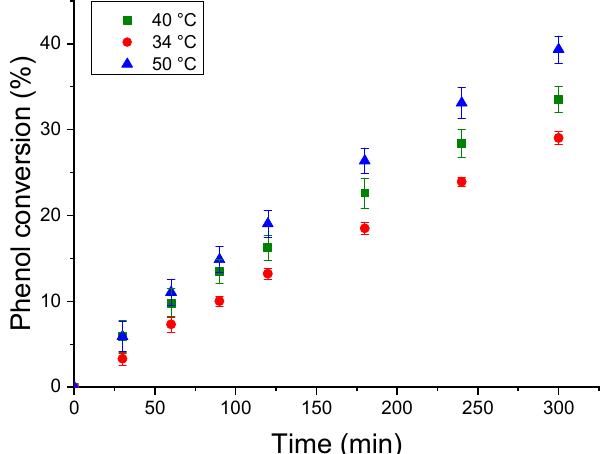
Figure 8. Photocatalytic degradation of phenol at different temperatures, fixing a catalyst loading of 0.125 g/L and an initial phenol concentration of 25 ppm.